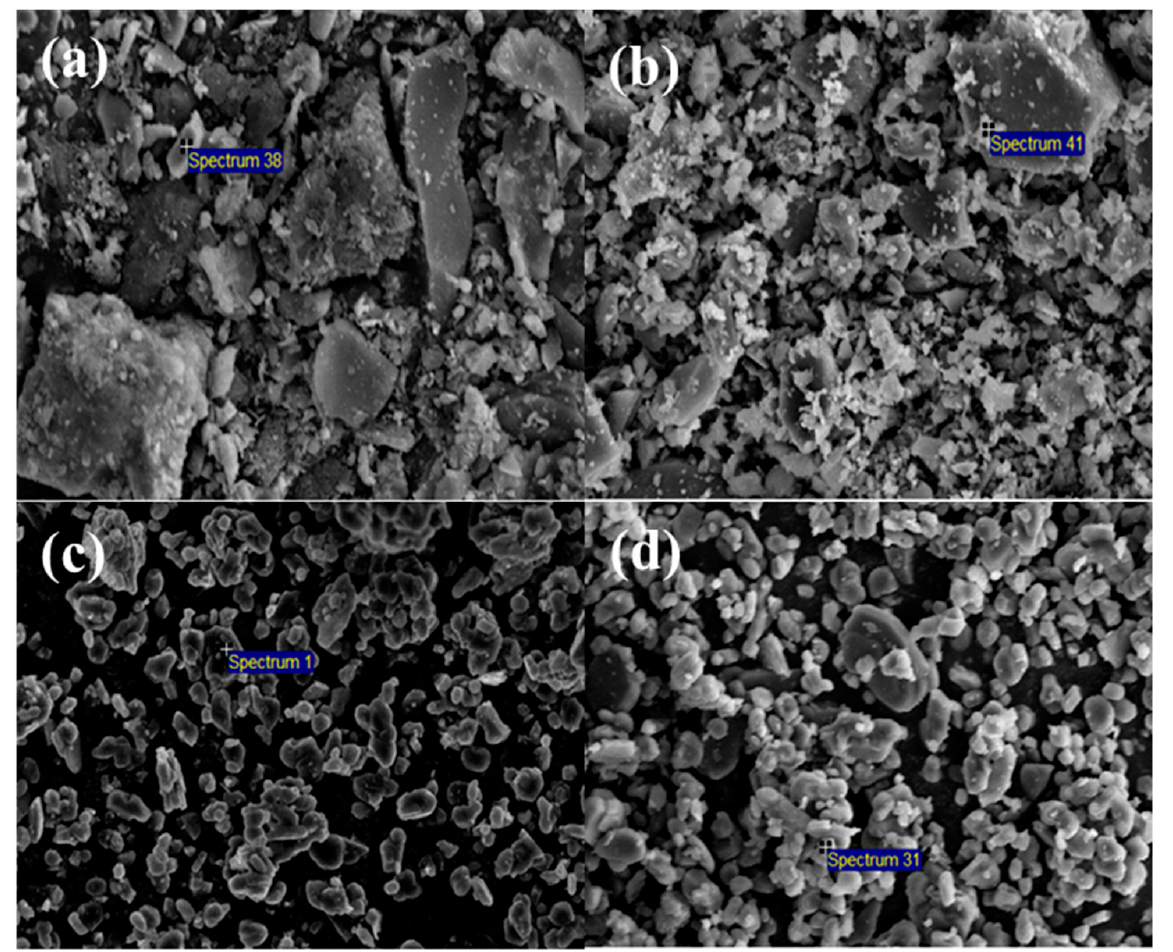
Figure 2. SEM images of WCI and α -alumina: ( a ) raw WCI, ( b ) WCI after roasting at 1250 °C, ( c ) raw α -alumina, and ( d ) α -alumina after roasting at 1250 °C.